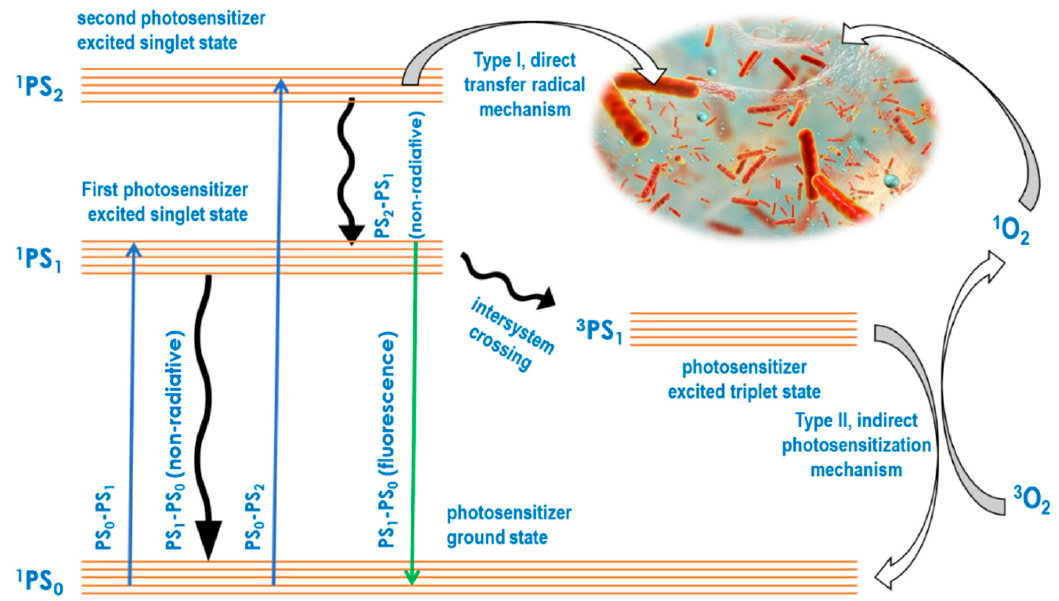
Figure 1. Jablonski diagram to illustrate the aPDT type I and II